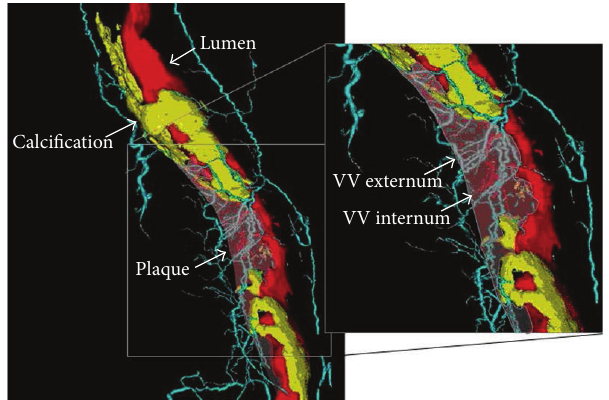
Figure 1: Volume-rendered micro-CT imaging of a coronary plaque and vasa vasorum. Volume-rendered 3D micro-CT image of a right coronary artery showing the main coronary lumen in red; noncalcified and calcified plaque areas are indicated by the arrows (noncalcified plaque is transparent). Vasa vasorum (VV) are shown in light blue (VV externa) or red (VV interna, directly originating from the main lumen). Reprint with permission from